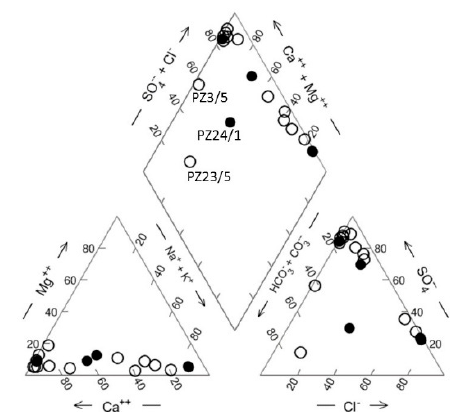
Figure 11. Piper diagram showing the different water-type, ranging between the Ca-SO 4 , Na-SO 4 , Ca-HCO 3 and Na-Cl hydrofacies. Samples deviating from the chloride-sulphate trend (see text) are labelled.